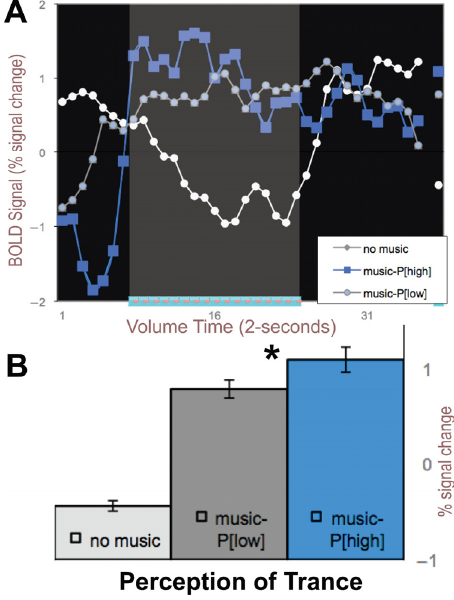
the right hemisphere. This region in right auditory cortex was modulated by the percep- tion of trance (yellow dot and yellow box in Figure 3B), as it was significantly below the line of equality (orange line). For comparison, all other brain regions from the GLM anal- ysis that passed our Bonferroni threshold and spatial voxel clustering [14] are also plotted in Figure 3. All brain regions were mapped with the GLM from anatomical locations were used from relevant studies of [3] and [13]. Area prostriata, right parietal, foot motor area- Bar+DeSouza , caudate Bar+DeSouza , putamen Bar+DeSouza , and supplementary motor cortex Bar+DeSouza also showed significantly enhanced signal for high trance perception (i.e., P[high] > P[low] ), with the exception of right visual cortex, left parietal, and cerebellum, whose data Figure 2. Right auditory cortex BOLD signals averaged across perceptual states of HIGH ( P[high] ) and points touched the line of unity (i.e., P[high] = P[low] ). We used anatomical locations of Figure 2. Right auditory cortex BOLD signals averaged across perceptual states of HIGH ( P[high] ) LOW trance perception ( P[low] ) from Figure 1. ( A ) BOLD signal averaged across the five blocks of 1-min PPC Hove and ACC Hove from [3] to further probe our data (red drop shaded area in Figure and LOW trance perception ( P[low] ) from Figure 1. ( A ) BOLD signal averaged across the five of music and color-coded (blue = high; gray = low) perception of trance. White line depicts when no 3) and found that these areas were also associated with a higher percept for trance ( p <0.05; blocks of 1-min of music and color-coded (blue = high; gray = low) perception of trance. White line i.e., P[high] > P[low] ). music was played. ( B ) Average BOLD signal for these states. *- signifies p < 0.01 paired t -test. depicts when no music was played. ( B ) Average BOLD signal for these states. *- signifies p < 0.01 paired t -test.